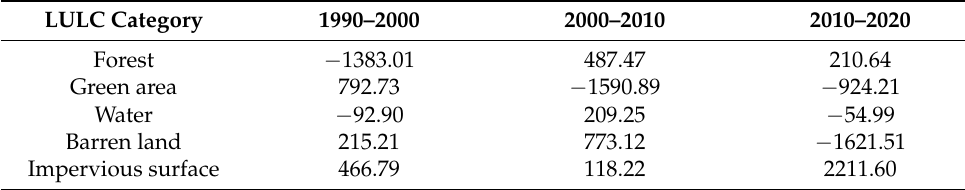
Table 13. Gains and losses of each category (km 2